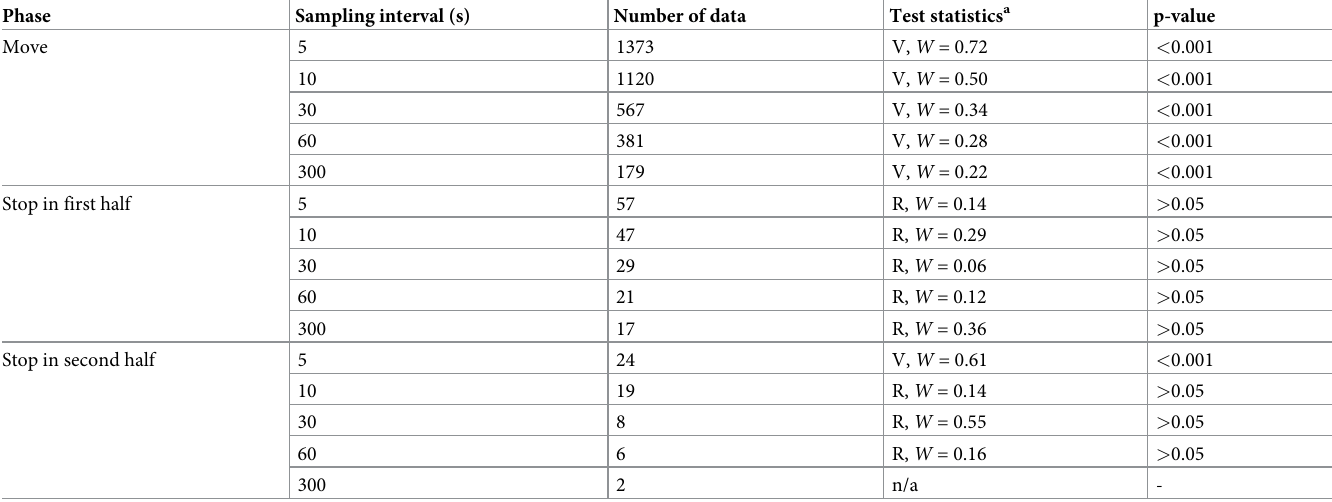
a n/a indicates that there were too few data points to test. The V-test (V) with a mean vector of 0˚ was used when a null hypothesis of uniform distribution was rejected by the Rayleigh test